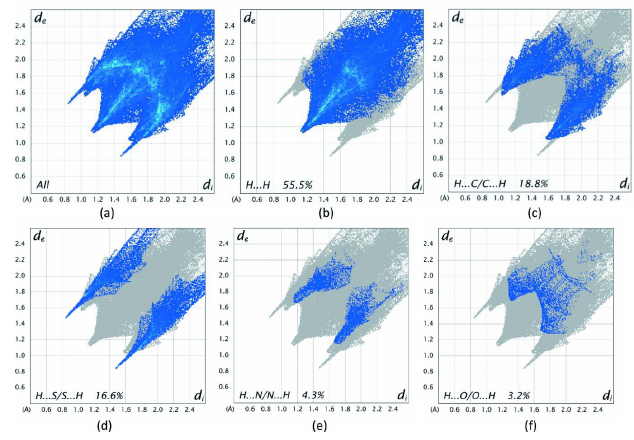
Figure 7 A full two-dimensional fingerprint plot for 1 , ( a ), together with separate principal contact types for the molecule ( b )–( f ). These were found to be H (cid:2)(cid:2)(cid:2) H, H (cid:2)(cid:2)(cid:2) C/C (cid:2)(cid:2)(cid:2) H, H (cid:2)(cid:2)(cid:2) S/S (cid:2)(cid:2)(cid:2) H, H (cid:2)(cid:2)(cid:2) N/N (cid:2)(cid:2)(cid:2) H and H (cid:2)(cid:2)(cid:2) O/O (cid:2)(cid:2)(cid:2) H